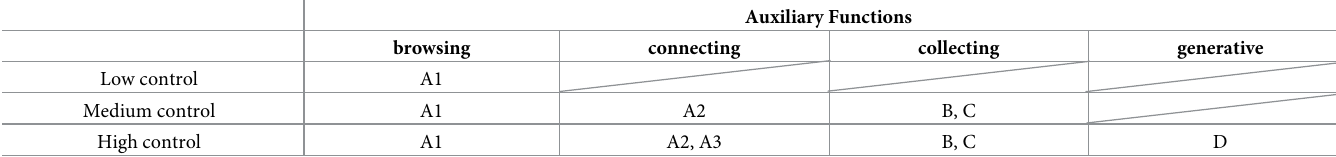
Table 2. Three versions of exhibit with different number of AR learner control